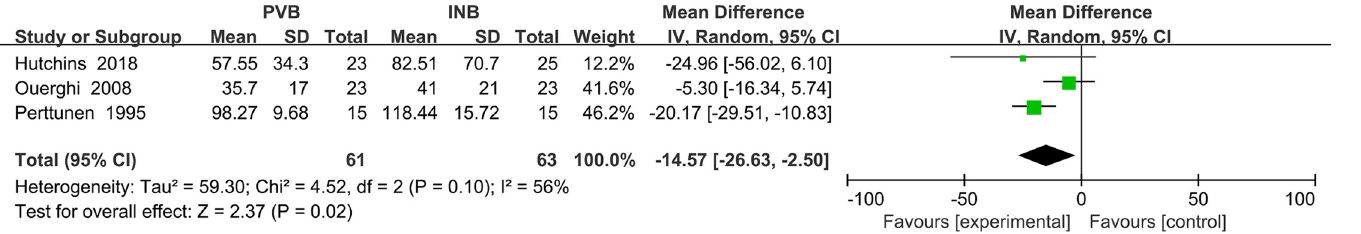
Fig 18. Forest plot of comparison: PVB VS INB. Outcome: Postoperative use of morphine.